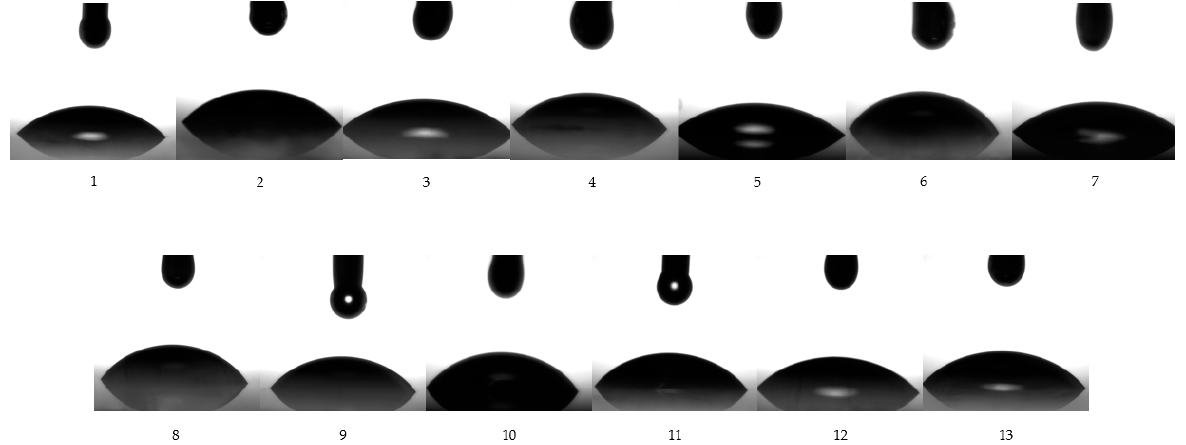
Figure 10. Captures for microemulsion drops (1–13), placed on the glass slide, in contact angle model study, evaluating γ LG and CA at 25 ± 0.5 °C.